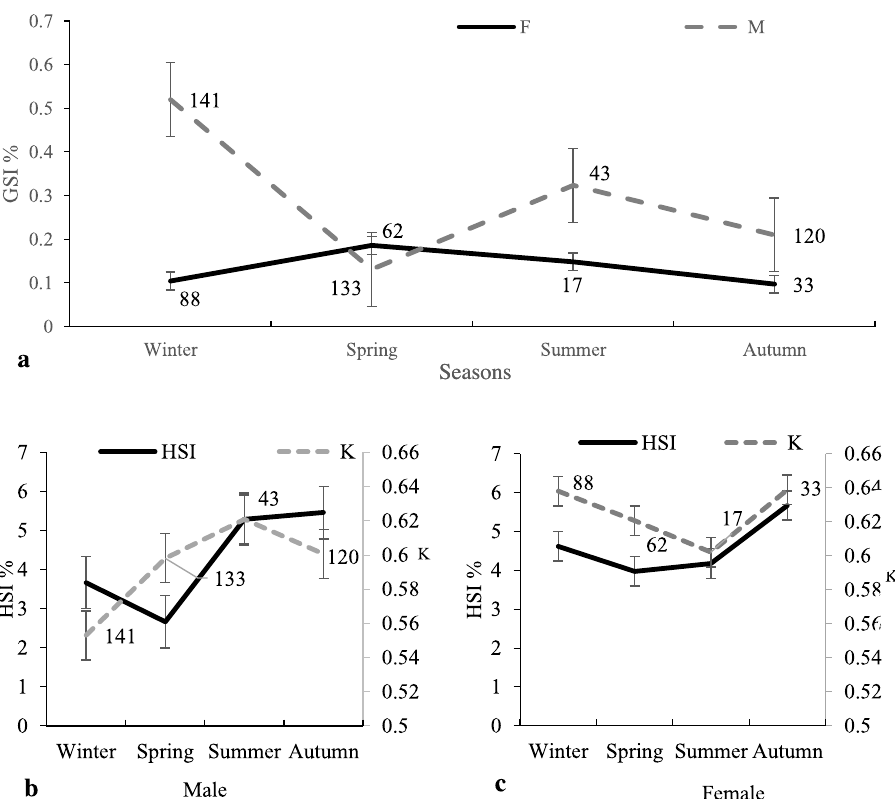
Fig. 8. Physiological indexes of P. blennoides from the Algerian coast (vertical bars are standard deviations). a) gonadosomatic index (GSI); b) hepatosomatic index (HSI) and somatic condition factor (K) for males; c) hepatosomatic index (HSI) and somatic condition factor (K) for